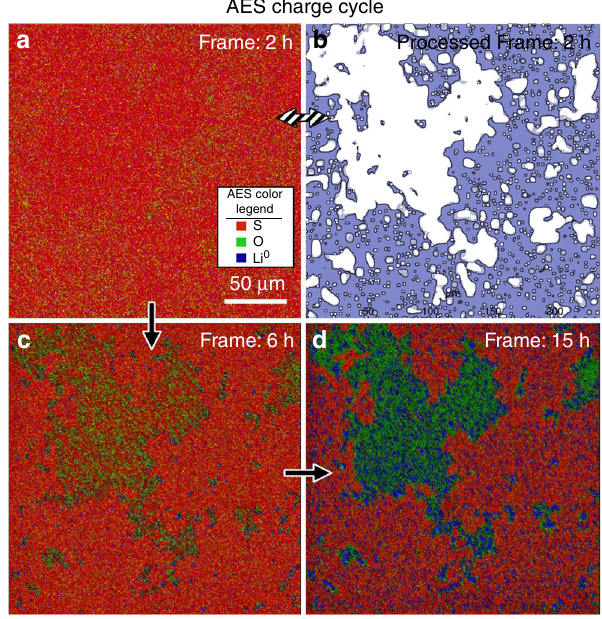
Fig. 6 In situ AES mapping of SEI heterogeneity. a shows an AES mapping image of the LPS SEI after 2 h of charging. b is a threshold- fi lter processed version of the same 2 h AES map, where white areas highlight little or no oxygen and blue areas represent higher oxygen concentrations, likely in the form of Li 3 PO 4 . c , d show the SEI after 6 and 15 h of charging, respectively